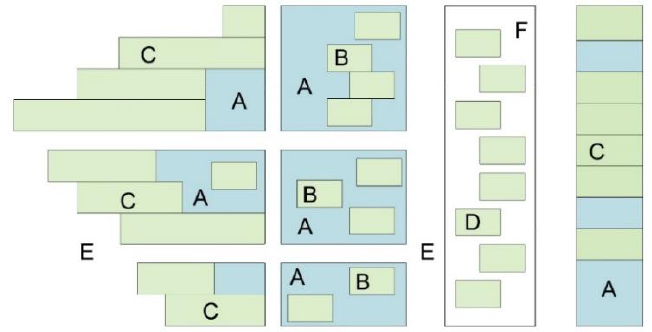
Figure 9. A schematic model of the Floating Fields in Shenzhen, China, growing edible plants on water rafts. Legend: A—pond with water (aquaculture), B—rafts with edible plant seedlings, C—soil cultivation area, D—soil cultivation area on the roof, E—public space, F—pavilion, in the interior and roof on which mulberry bushes are grown and silkworms are bred